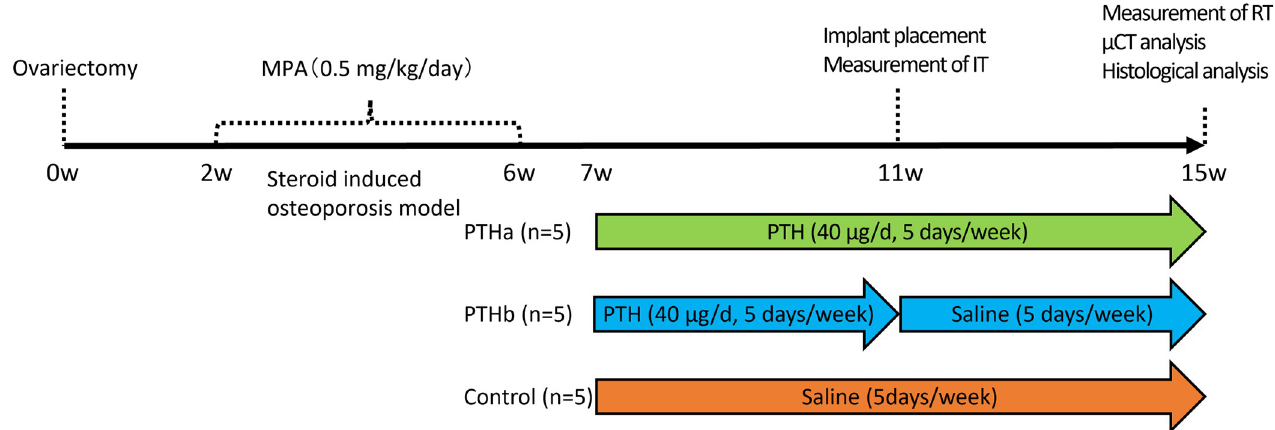
Fig 1. Study design. Rabbits underwent ovariectomy (n = 15); 2 weeks later, ovariectomized rabbits steroid injections were initiated for 4 weeks, and the steroid-induced model of osteoporosis was prepared. Seven weeks after ovariectomy, the PTHa group was injected with PTH for 8 weeks; the PTHb group was injected with PTH for 4 weeks; and the Control group was injected with saline for 8